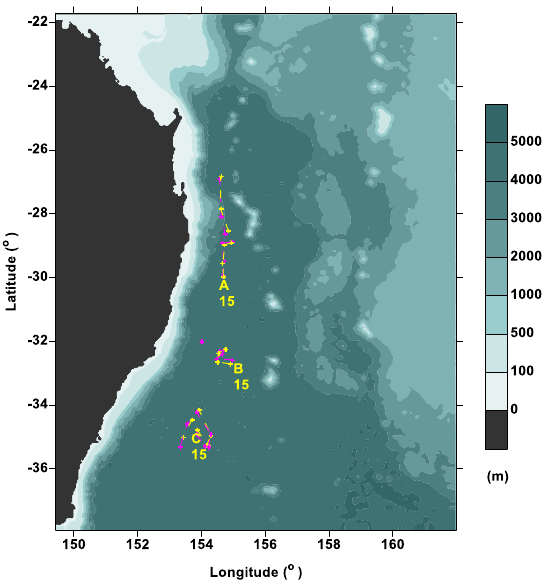
Fig. 11 Tracks of eddies A , B , and C , for the simulation without tides (magenta) and with tides (yellow) at 7.5 day intervals after 15 days. The location at day 15 is labeled for each of the eddies and indicated with a